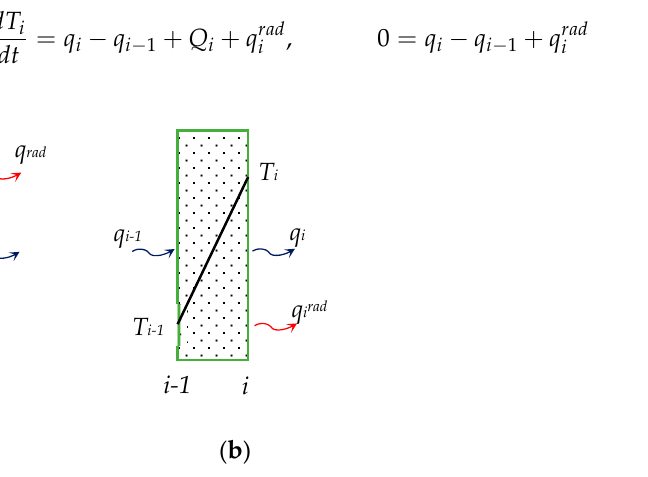
Figure 2. ( a ) Transient thermal element; ( b ) Thermal insulation element.